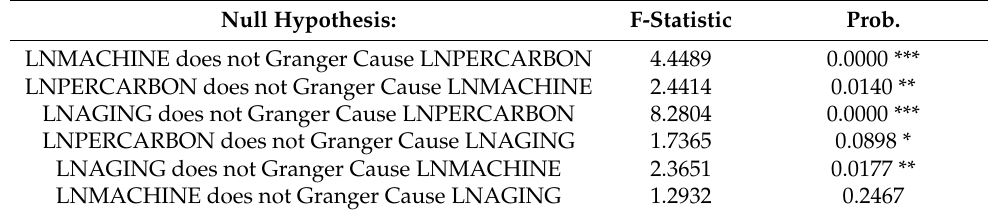
Table 9. Pairwise Granger causality tests. Null Hypothesis: F-Statistic Prob. LNMACHINE does not Granger Cause LNPERCARBON 4.4489 0.0000 *** LNPERCARBON does not Granger Cause LNMACHINE 2.4414 0.0140 ** LNAGING does not Granger Cause LNPERCARBON 8.2804 0.0000 *** LNPERCARBON does not Granger Cause LNAGING 1.7365 0.0898 * LNAGING does not Granger Cause LNMACHINE 2.3651 0.0177 ** LNMACHINE does not Granger Cause LNAGING 1.2932